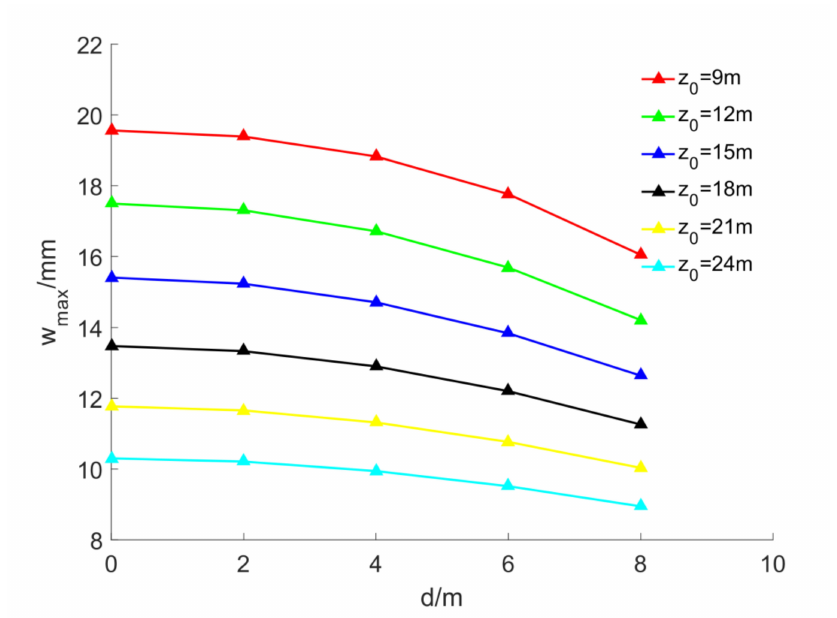
Figure 14. Influence of surcharge load and tunnel spacing on maximum longitudinal displacement of the existing